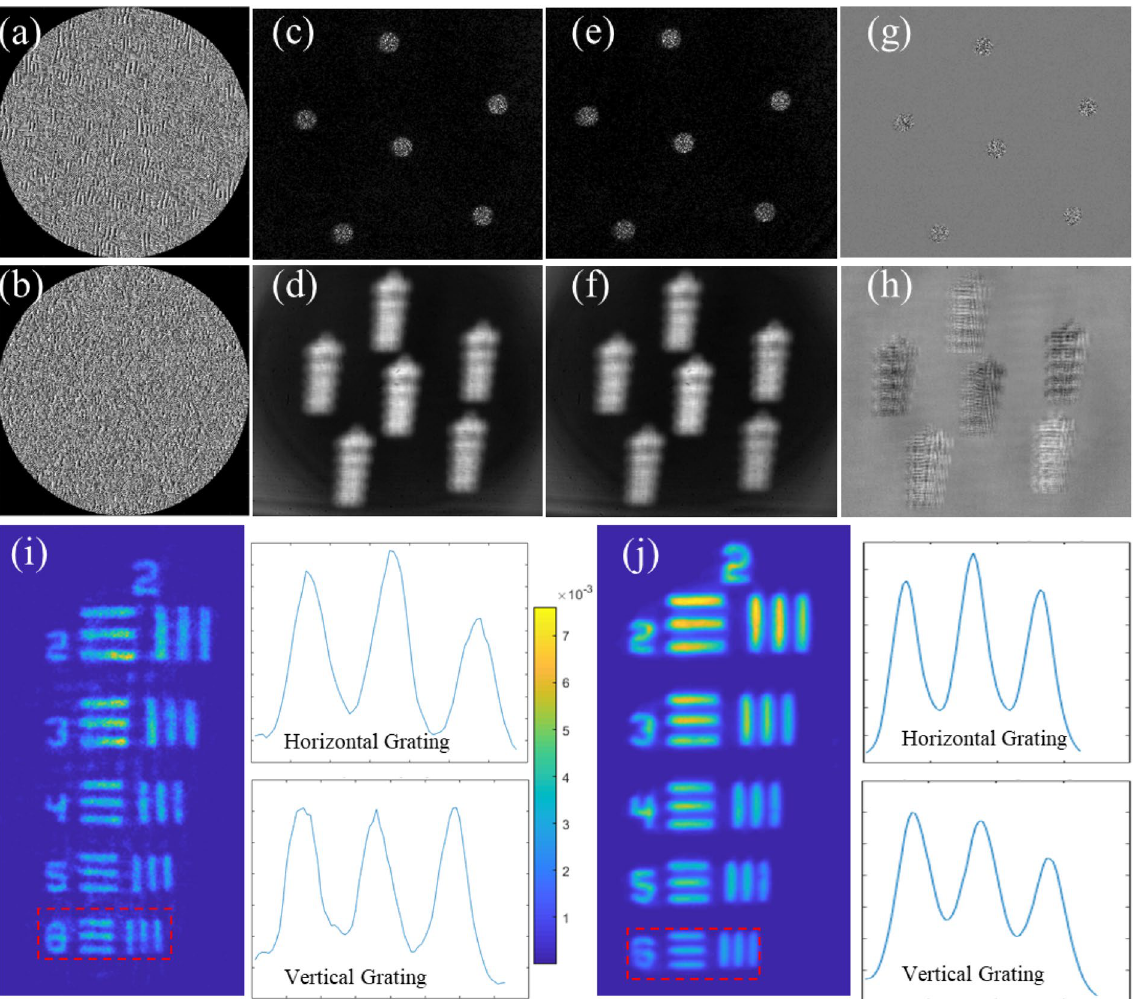
Figure 3. Reconstruction and imaging results of SCI-COACH and direct imaging system. ( a , b ) CPMs without the diffractive lens, ( c , e ) The two parts of the PSH, ( d , f ) The two parts of the object hologram, ( g ) Bipolar PSH, ( h ) Bipolar Object hologram, ( i ) SCI-COACH reconstruction result with average visibility plots of the 6th element, ( j ) Direct imaging result with average visibility plots of the 6th